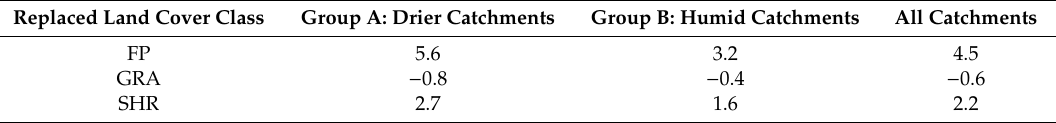
Table 2. Predicted water supply change due to the expansion of NF, expressed as percentage of annual runoff change per 10,000 ha of increased NF.